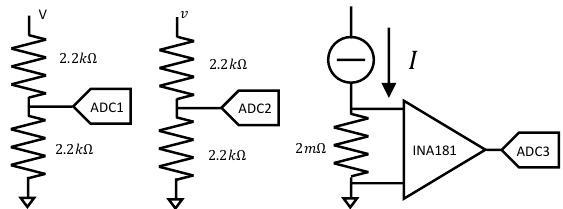
Figure 4. Signal conditioning circuit for online data acquisition.